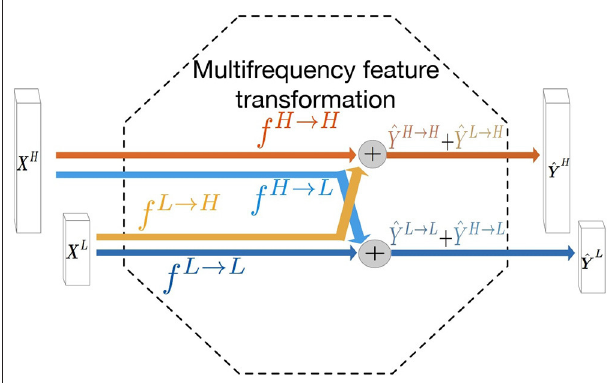
FIGURE 1 | Computation graph of the multifrequency feature transformation of octave convolution. The operation mainly contains two processes of the inter-frequency information exchange ( f L → H and f H → L ) and intra-frequency information update ( f L → L and f H → H ).